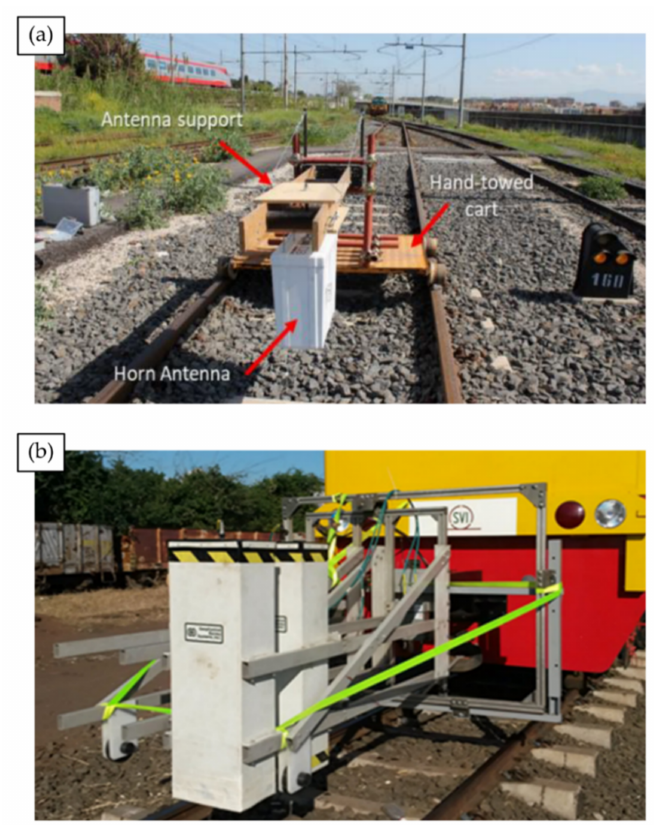
Figure 4. A selection of leading GPR systems. ( a ) Ballast fouling inspection trolley with selectable- frequency GPR antenna module [77]. ( b ) Loco-mounted fixed directional air-coupled GPR